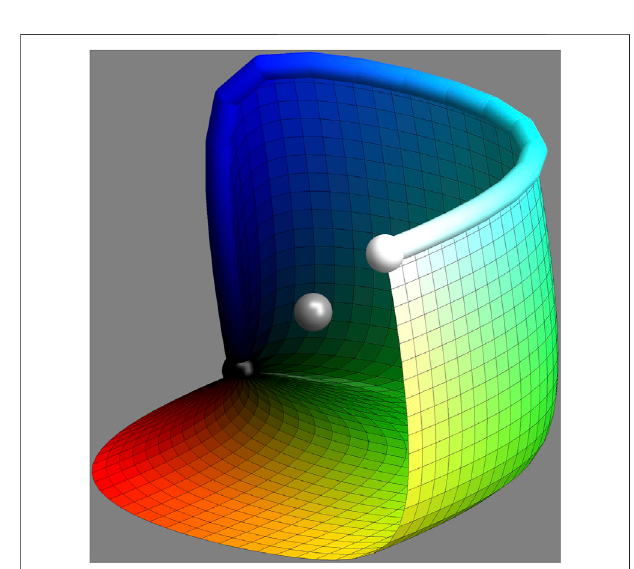
FIGURE 4 | This is the cool edge color curve and the surface constructed from its chords. This is one half of the surface of the color solid. The other half is obtained by central symmetry on the gray point — or the chords of the warm edge color curve. The gray sphere indicates the centre of